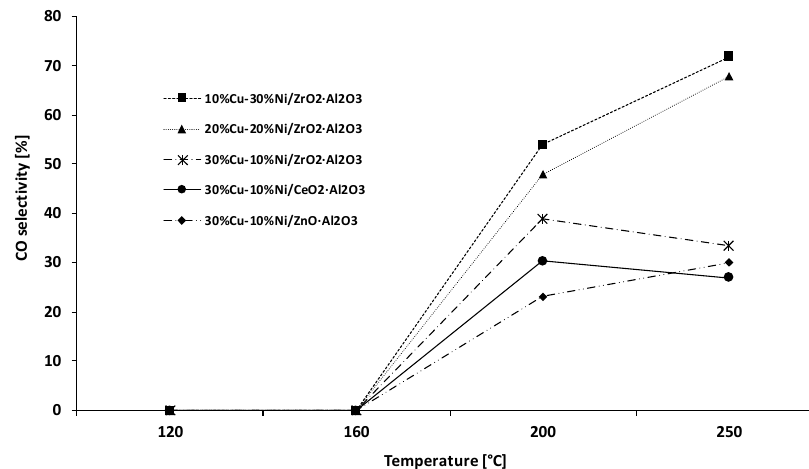
Figure 3. The influence of the reaction temperature of bimetallic catalysts on the selectivity towards CO 2 formation in the OSRM process.